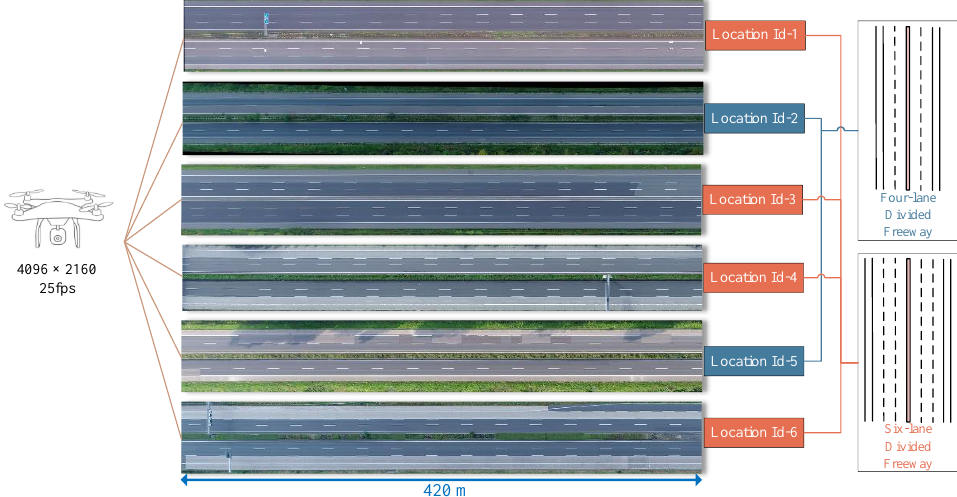
Figure 1. An aerial view of the straight sections on the test freeways. Table 2. Information and data collection for each location.